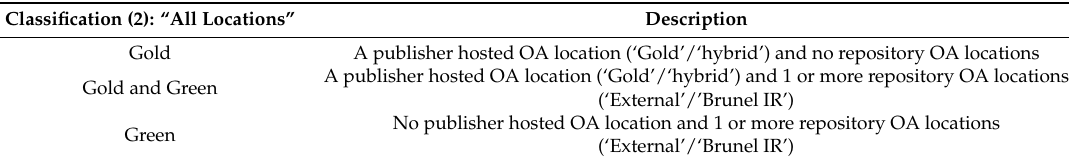
Table 2. The open access classification (2) by all available locations. Classification (2): “All